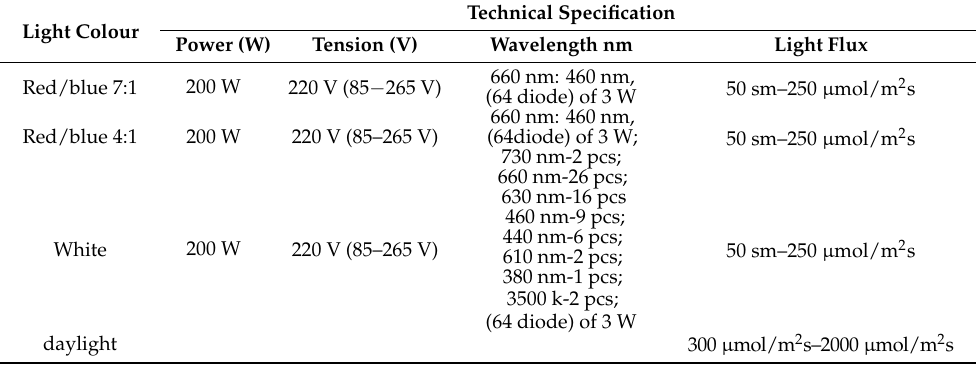
Table 7. LED bulb